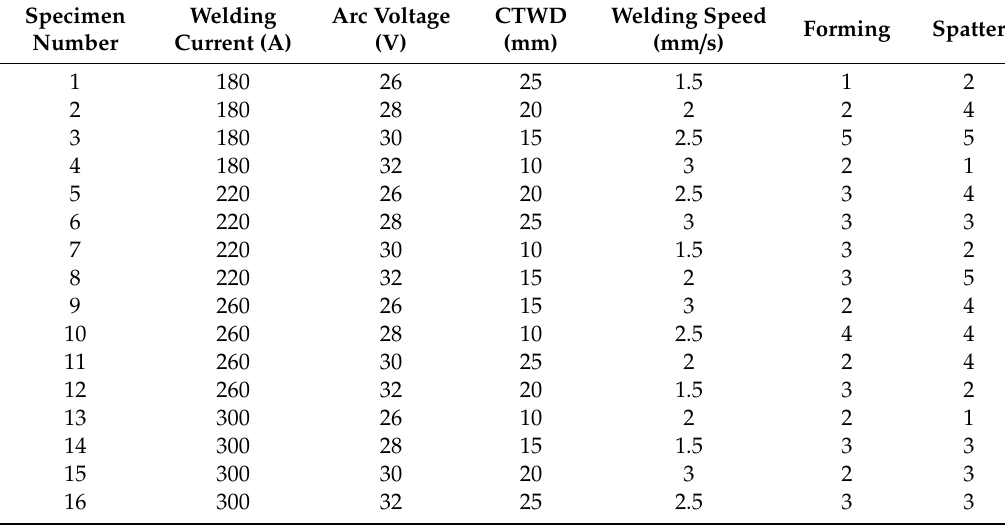
Table 3. Process parameters of the orthogonal test.